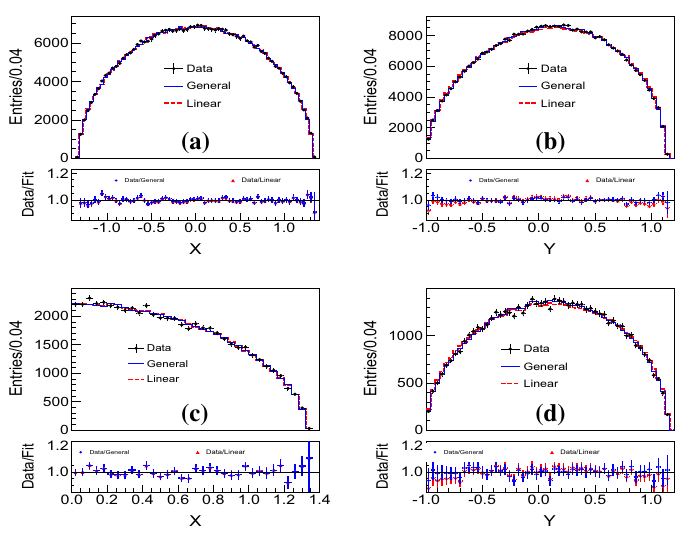
Figure 2. Projections of the fit results onto (a) X and (b) Y for η (cid:3) → ηπ + π − , (c) X and (d) Y for η (cid:3) → ηπ 0 π 0 in the general (solid histograms) and linear (dashed histograms) representations, where the dots with error bars represent data.